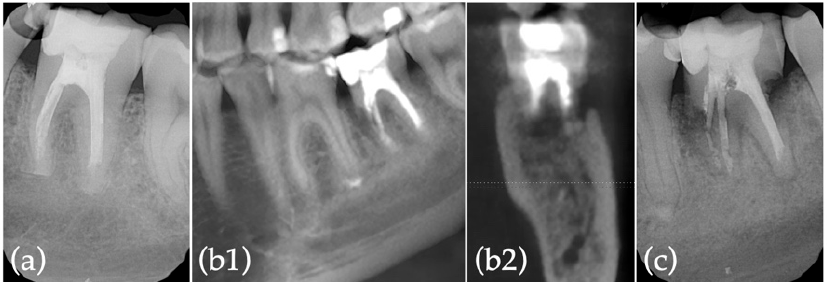
Figure 2. Radiographic records of IR postoperative controls: ( a ) 9-month follow-up; ( b1 ) sagittal and ( b2 ) coronal CBCT sections of the region of interest at 20-month follow-up; ( c ) 2.5-year follow-up. 2.2. Extraction with Alveolar Ridge Preservation Using Leukocyte-Platelet Rich Fibrin